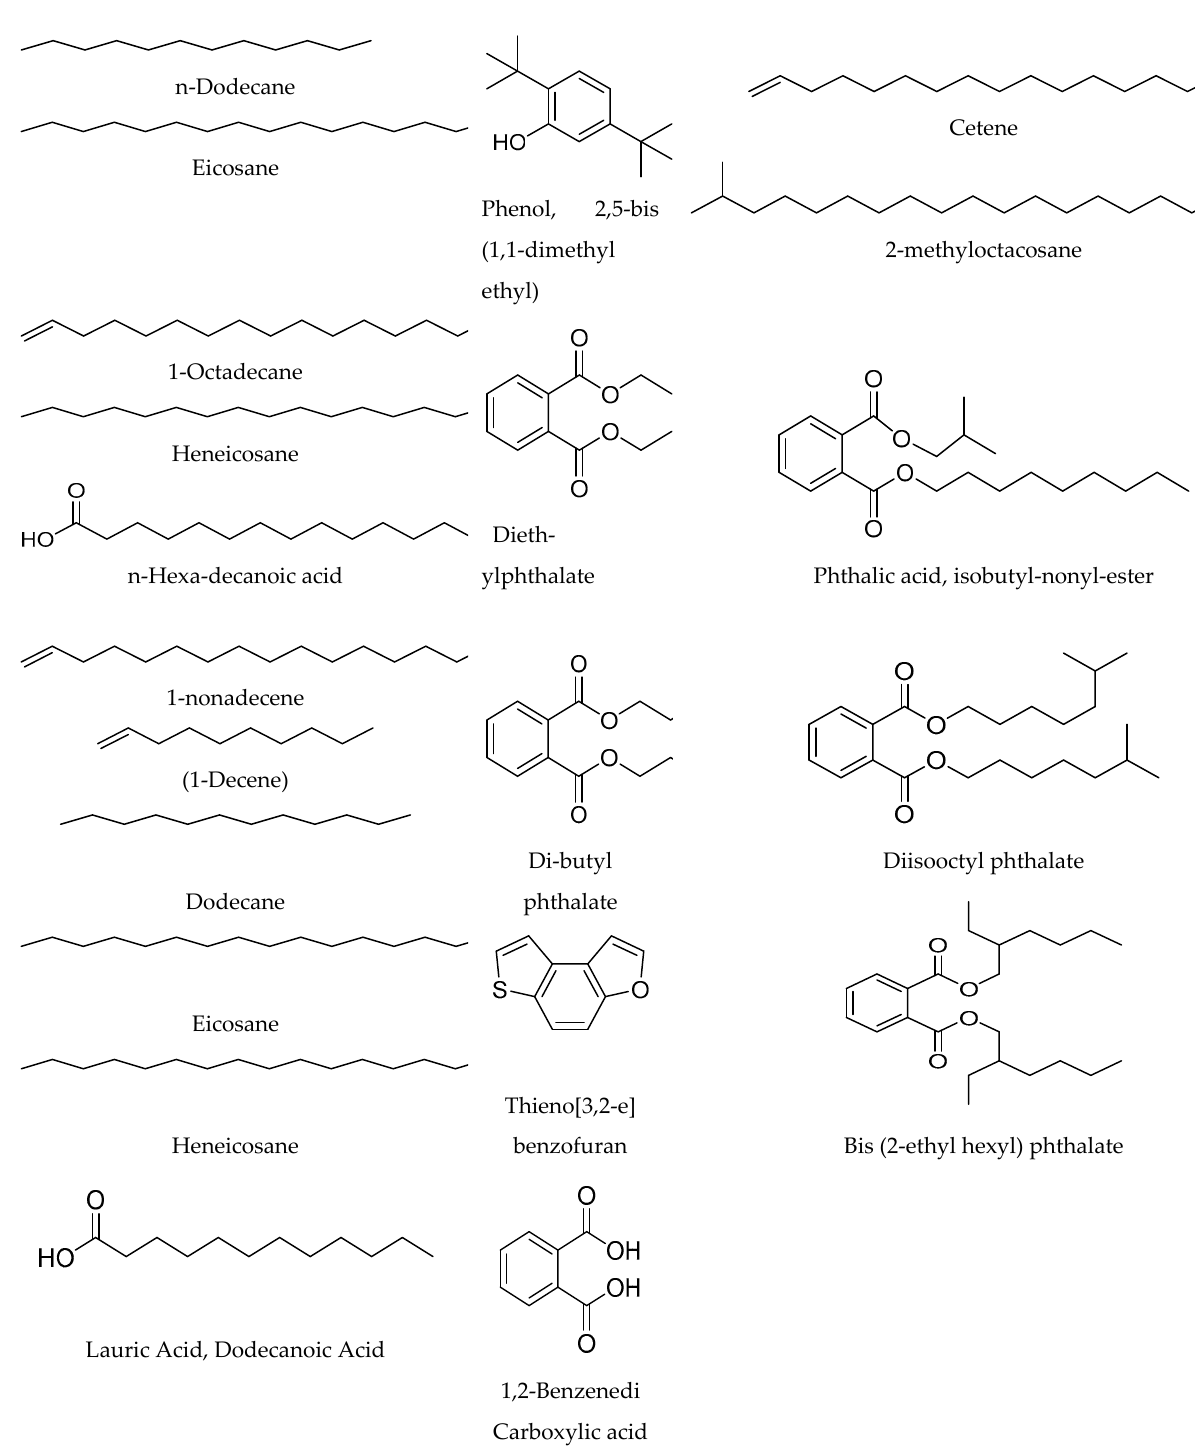
Figure 4. The chemical structure of the antimicrobial compounds identified by GC-MS from crude extract of SUK 25.